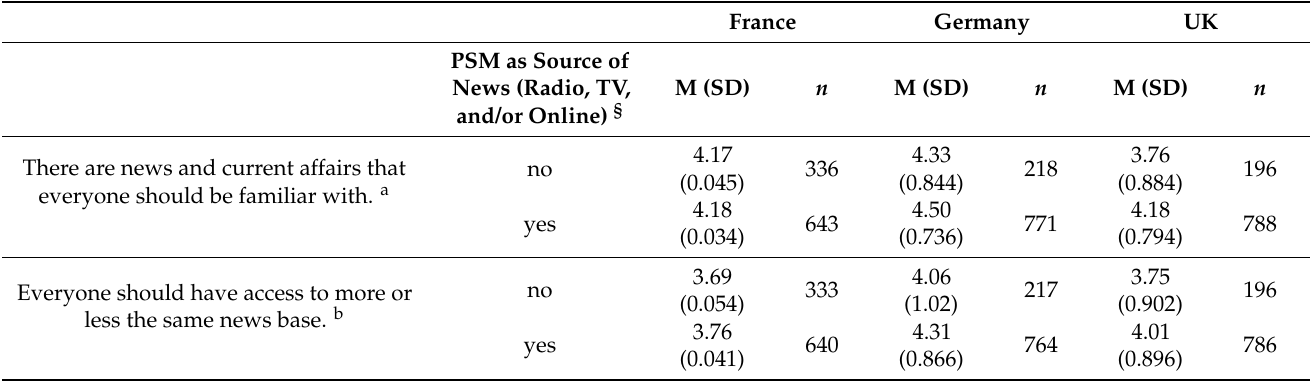
Table 3. The importance of a shared public